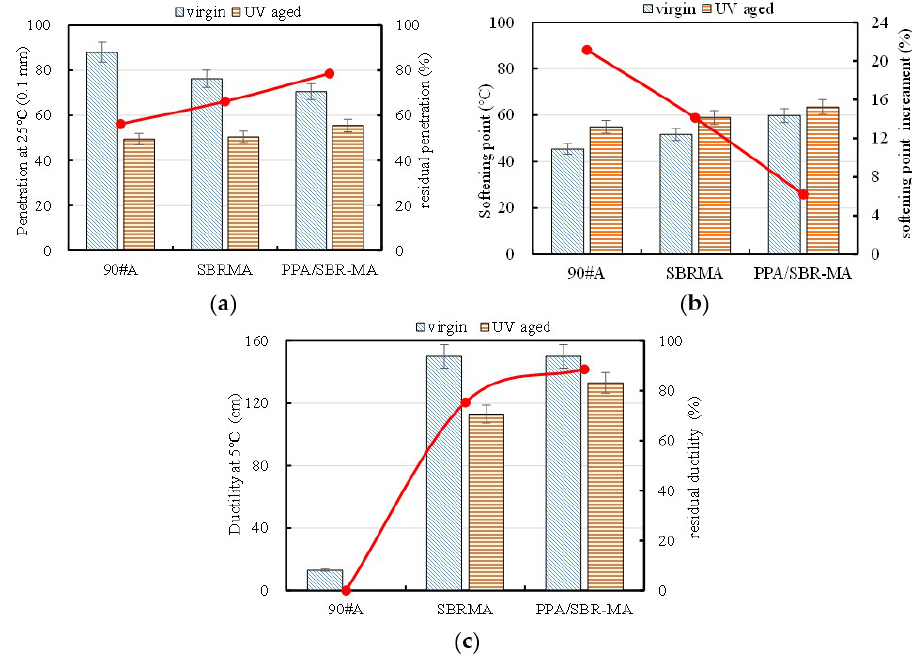
Figure 5. Basic property test results. ( a ) Penetration; ( b ) Softening point; ( c )